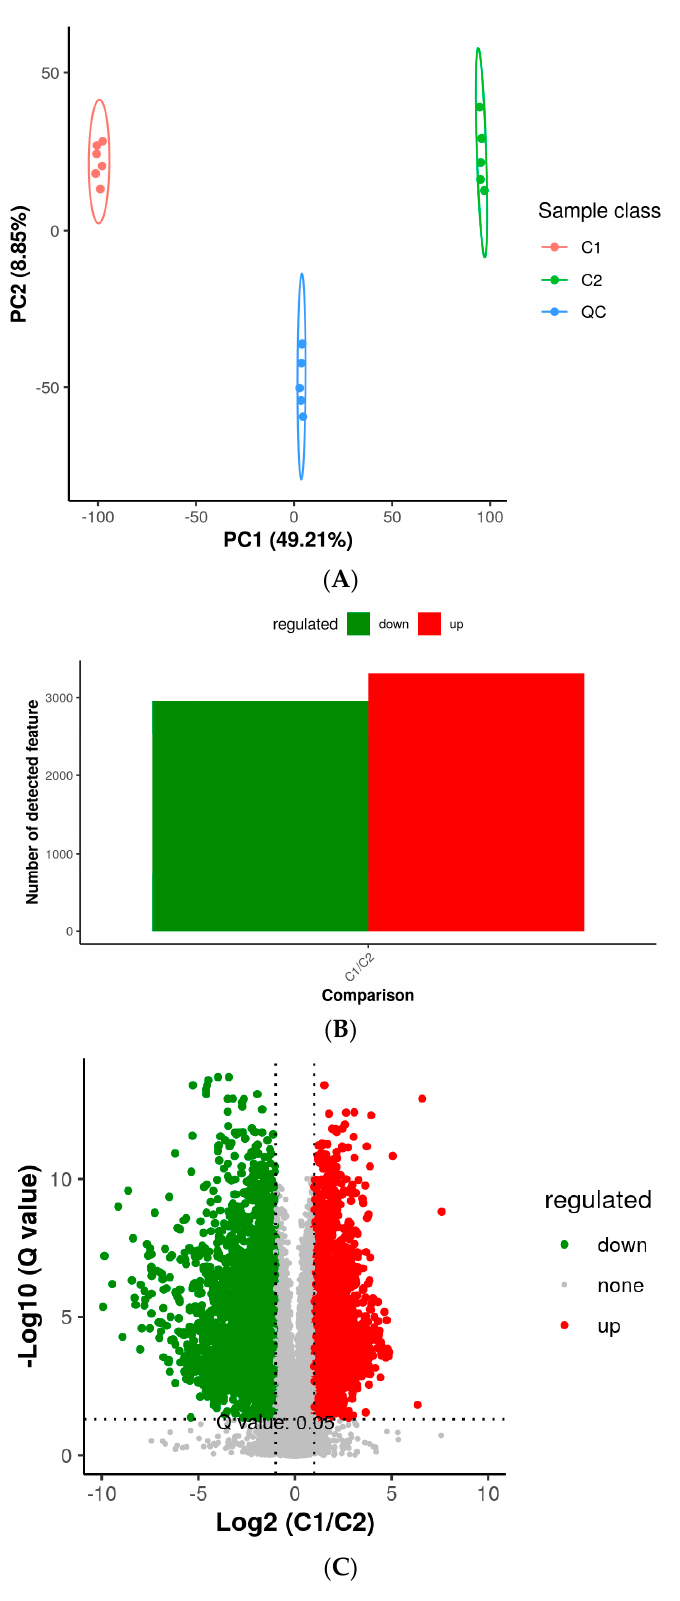
Figure 3. DEM profile. ( A ) PCA score map; ( B ) Comparison of DEMs between young “Green Peel” and mature “Red Peel” sweet cherry trees; ( C ) Volcano plot of DEMs.